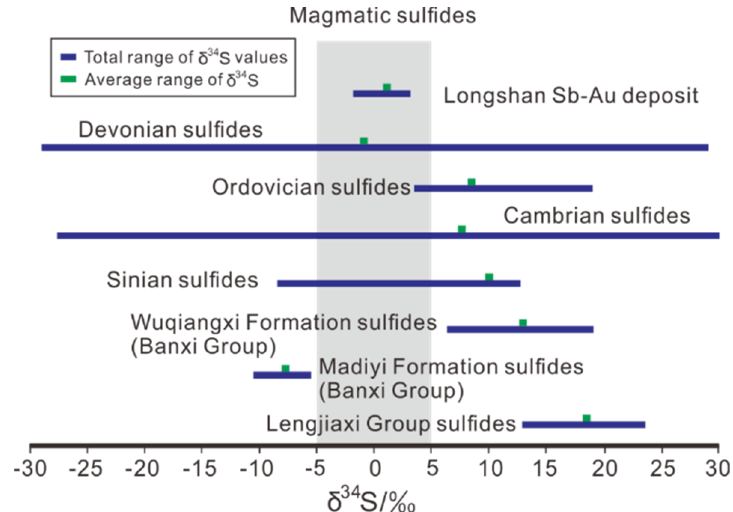
Figure 13. Sulfur isotope composition from the Longshan Sb-Au deposit, South China (Stratum sulfur isotope compositions data are from Hu et al. [28]).